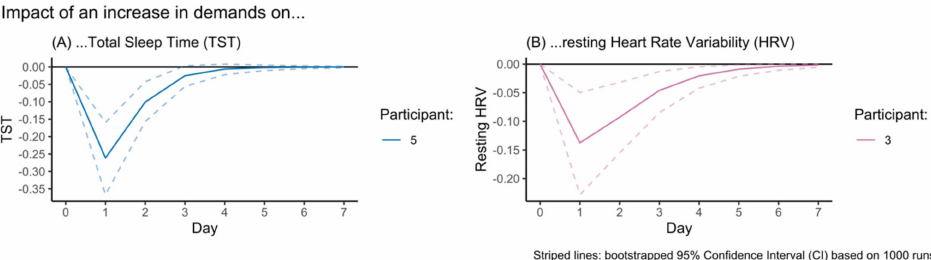
Figure 1. Visualization of the Impulse Response Function (IRF) of the impact of an increase in demands on the Total Sleep Time (TST) and resting Heart Rate Variability (HRV) during the subsequent week.